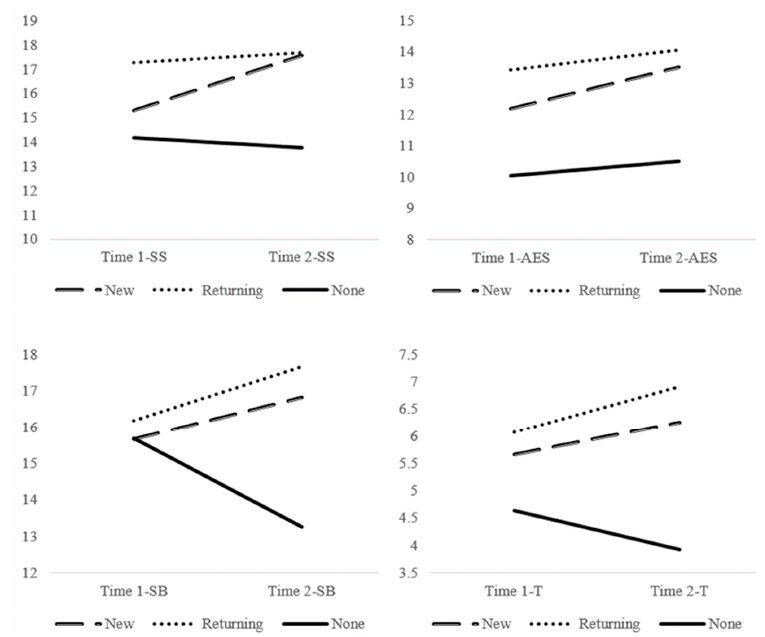
Figure 2. Group by time interaction shows a differential pattern of change was detected between the three intervention groups for the four GRF sub-scales; safety and structure, adult engagement and supervision, student behaviors, and